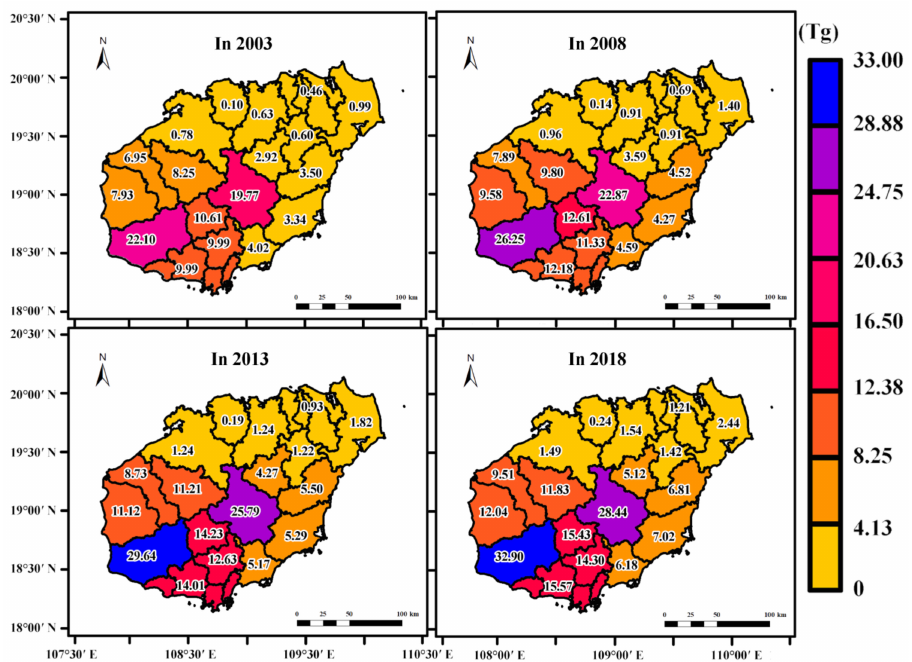
Figure 7. Distribution of tropical rainforest biomass in different cities and counties in Hainan Island from 2003 to 2018.